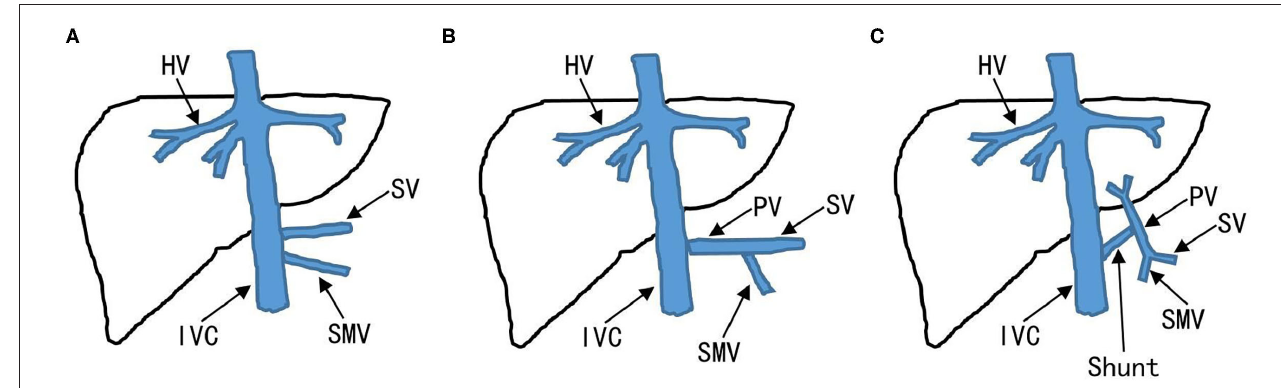
FIGURE 1 | Classification of EPSS. Absence of the PV to the liver is defined as EPSS type I. (A) EPSS type Ia: the SV and SMV drain respectively into IVC. (B) EPSS type Ib: the SV and SMV confluent into the IVC. (C) EPSS type II: existence of the PV to the liver. EPSS, extrahepatic portosystemic shunts; IVC, inferior vena cava; PV, portal veins; SMV, superior mesenteric vein; SV, splenic